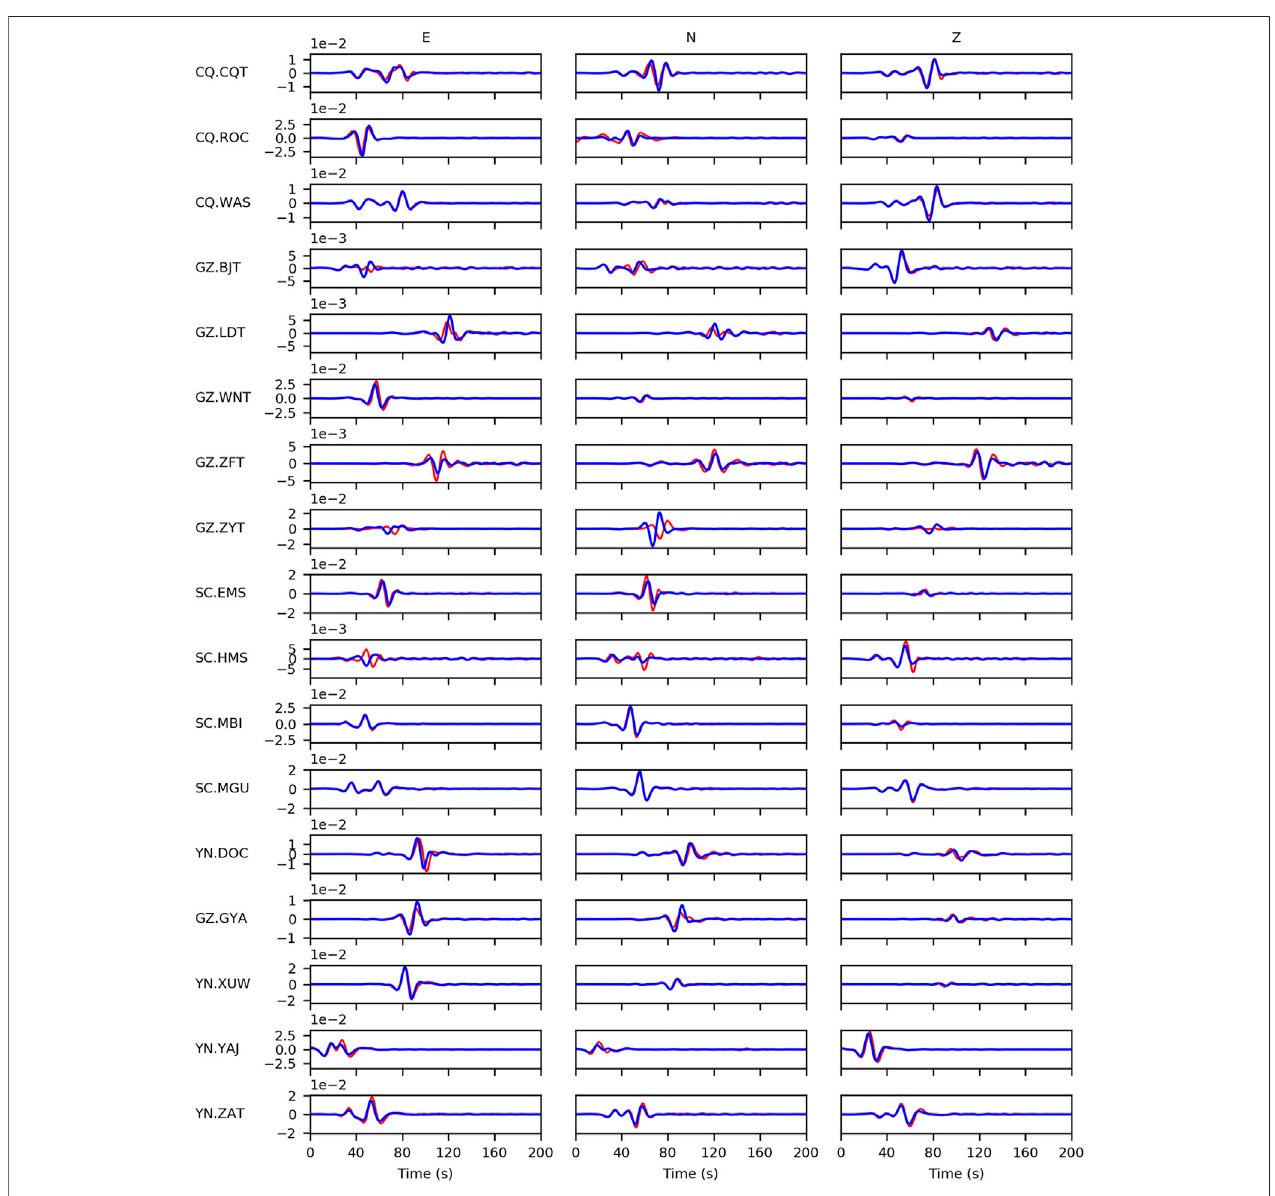
FIGURE 12 | As in Figure 11 , but for frequency range of 0.03 – 0.1